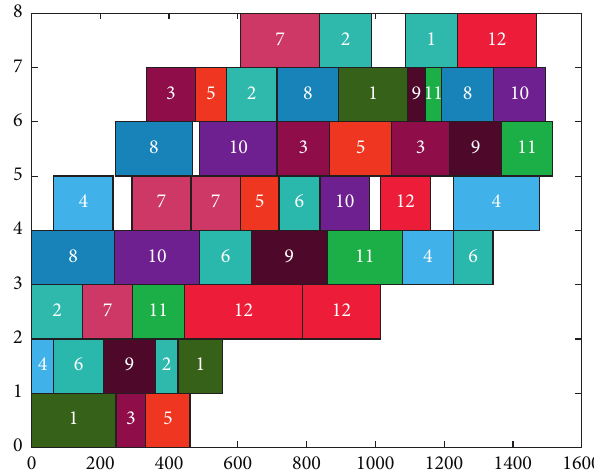
Figure 8: Gantt chart of an optimal solution to MFJS10 obtained by DOLGOA.